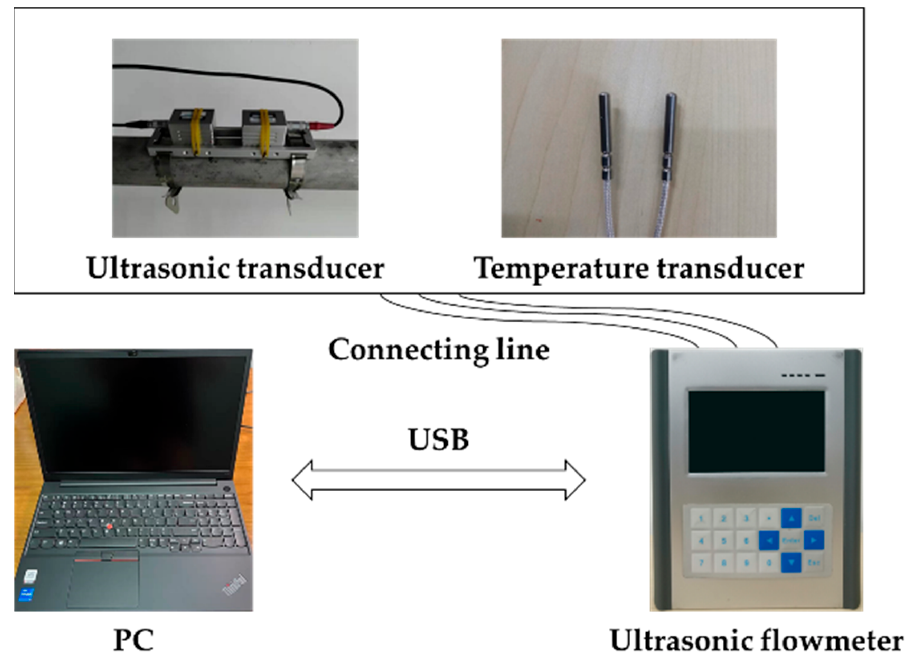
Figure 11. System composition of ultrasonic flowmeter.